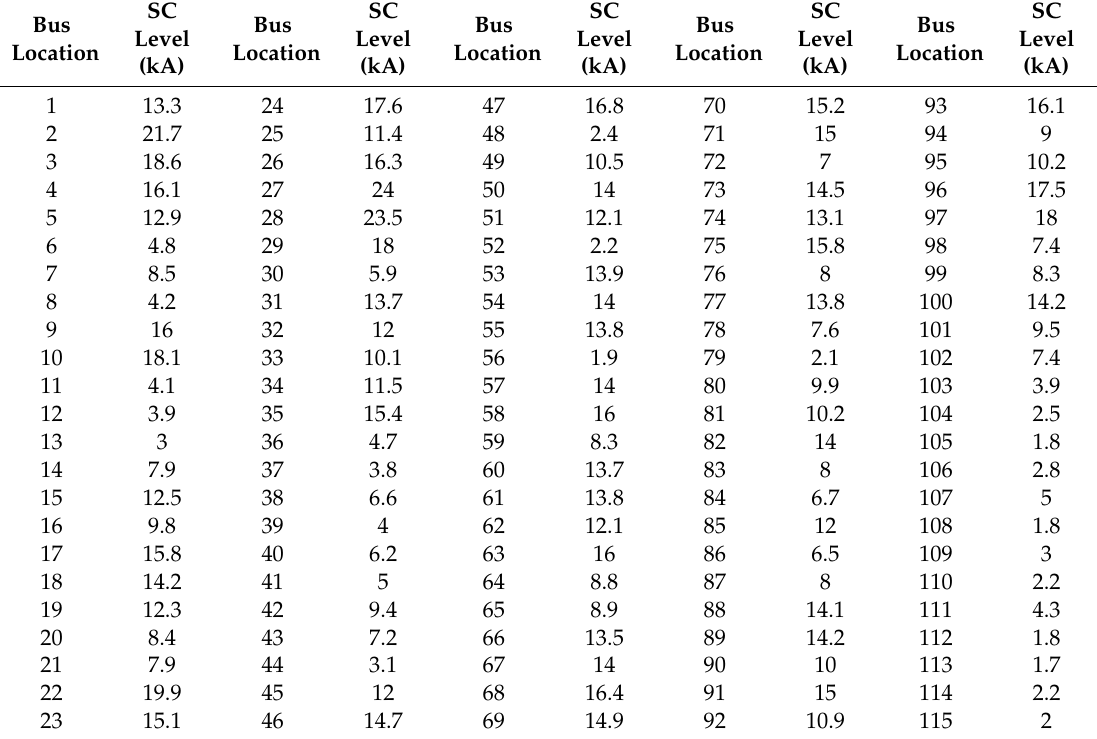
Table 9. The short circuit level of each bus in BREC after DG allocation.